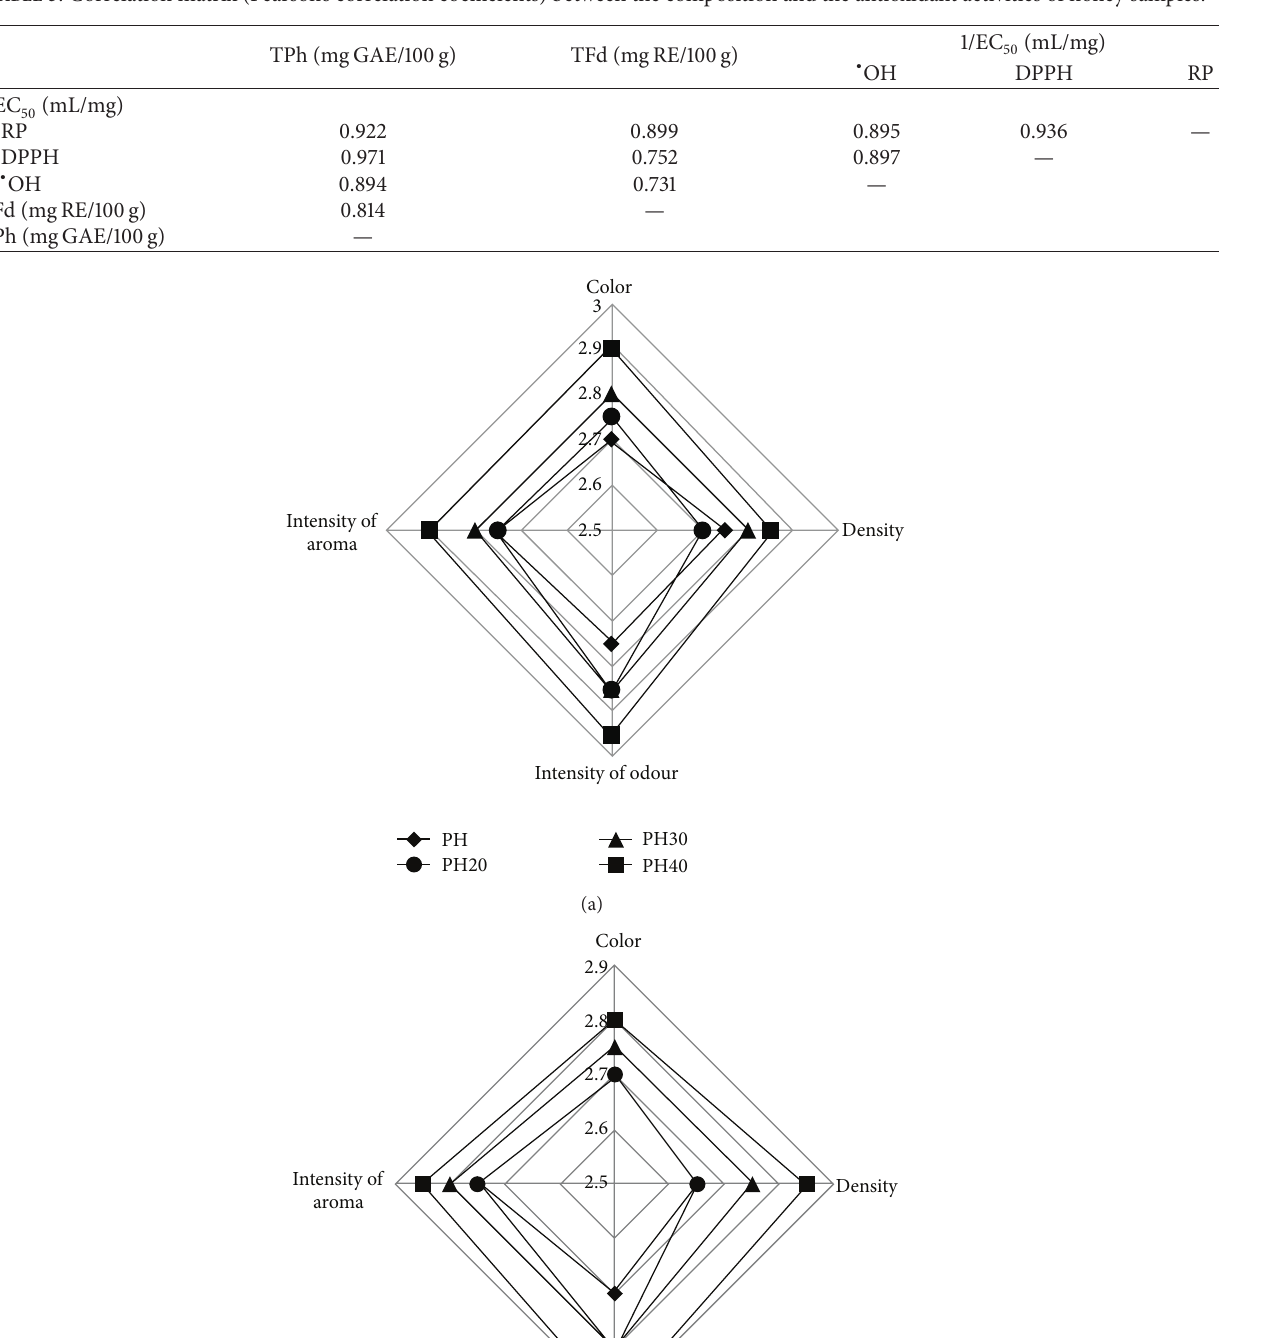
Table 3: Correlation matrix (Pearson’s correlation coefficients) between the composition and the antioxidant activities of honey samples.